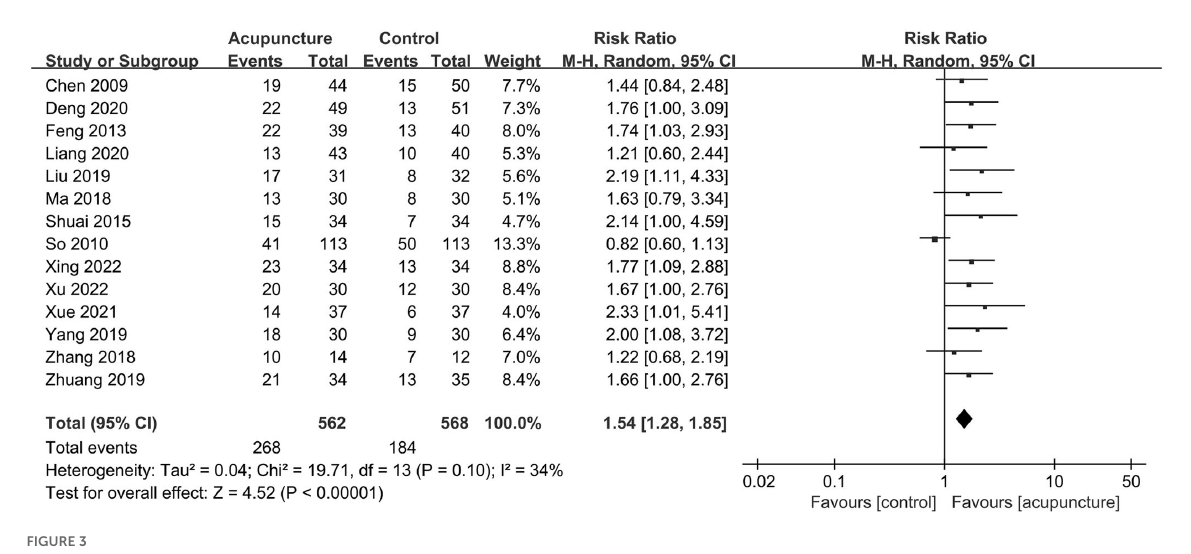
FIGURE3 Forest plot of clinical pregnancy